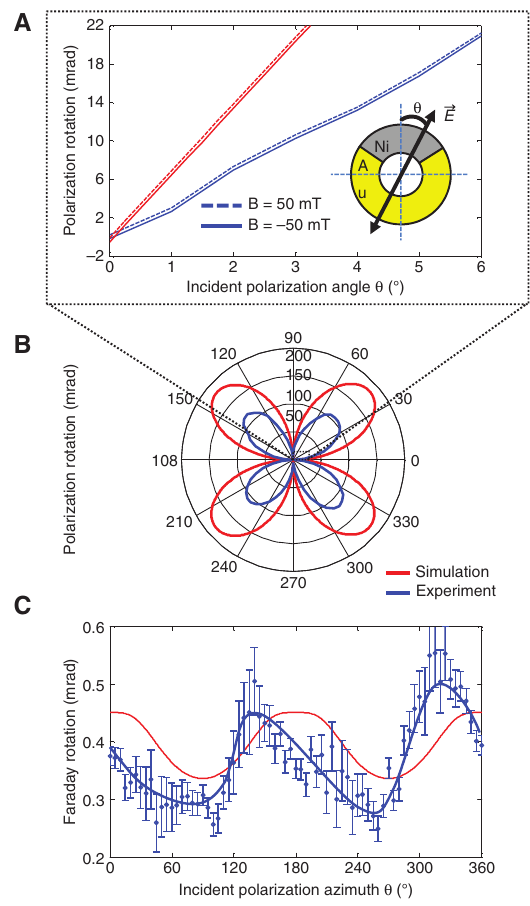
Figure 3: Sample optical anisotropy. (A–B) Rotation of the polarization azimuth of a beam transmitted through the sample (135 ° Ni sector). Red lines represent compu- tational analysis, and blue lines stand for experimental results. Solid and dashed lines represent opposite directions of external magnetic fields. θ is the angle of polarization azimuth in reference to the symmetry axis of the metamaterial array. (C) The effect due to the presence of the external magnetic field appears as the dif- ference between the solid and dashed lines plotted in (A) and (B). The red line corresponds to numerical results, while blue circles represent experimental measurements. The blue line is a guide for the